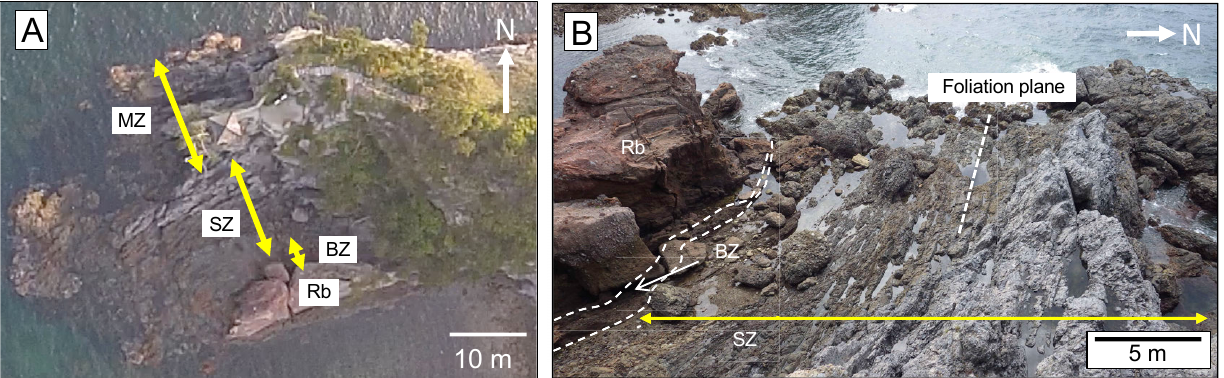
Figure 5: [A] Aerial drone image shows the zone classification of obsidian lithofacies; brecciated obsidian (BZ), sheared brecciated obsidian (SZ), and massive to brecciated obsidian (MZ) zones from south to north. The upper side of this photo shows the northern region. Rb – the rotated block of the Kannonzaki pyroclastic rocks. [B] Photograph (view to the west) showing the occurrences of the zones. The foliation planes (dotted line) are clearly developed in the sheared brecciated zone.